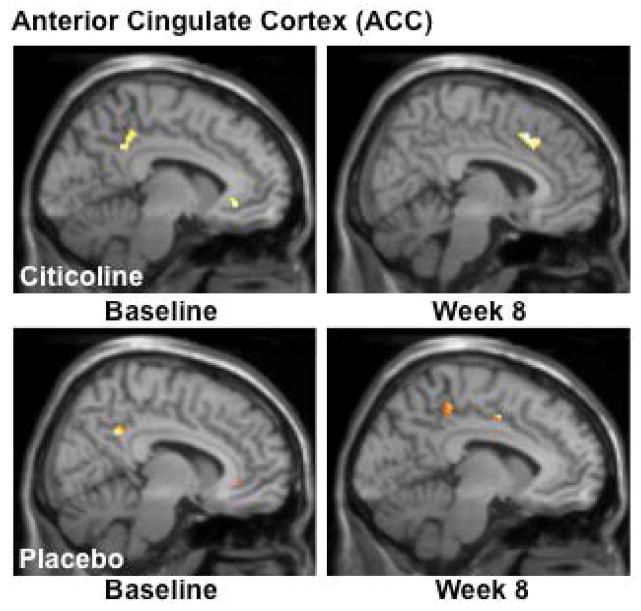
fMRI Analysis of the Multi-Source Interference Task (MSIT): Interference-Control ConditionAnalyses of MSIT (Interference task minus Control task) activation revealed a shift from posterior to more anterior ACC activation, with a corresponding slight increase in total voxel cluster size from baseline to treatment week 8 in the citicoline-treated group. The placebo-treated group also demonstrated activation in posterior ACC at baseline, but following 8 weeks of treatment, activation shifted slightly more anteriorly and remained in posterior and mid ACC. (k = total cluster size with p < 0.01(uncorrected) and a threshold of ≥ 10 voxels).